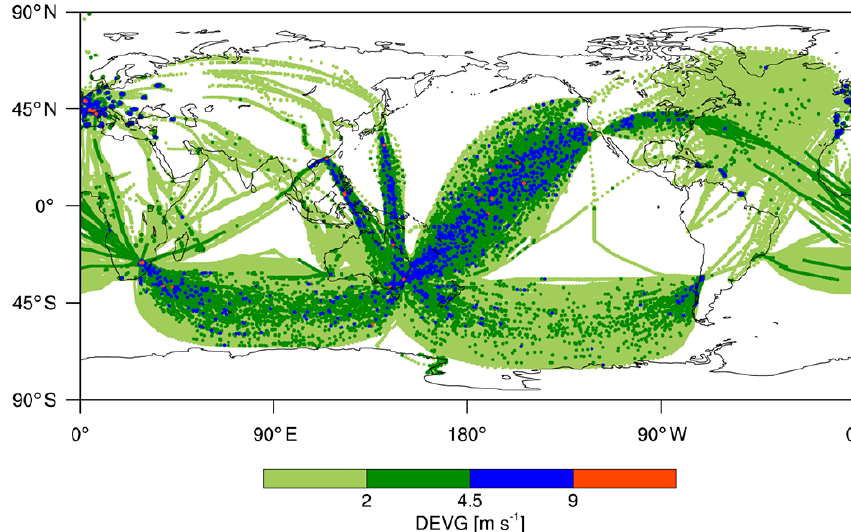
Figure 6. As in Fig. 2, except for the QCDEVG.